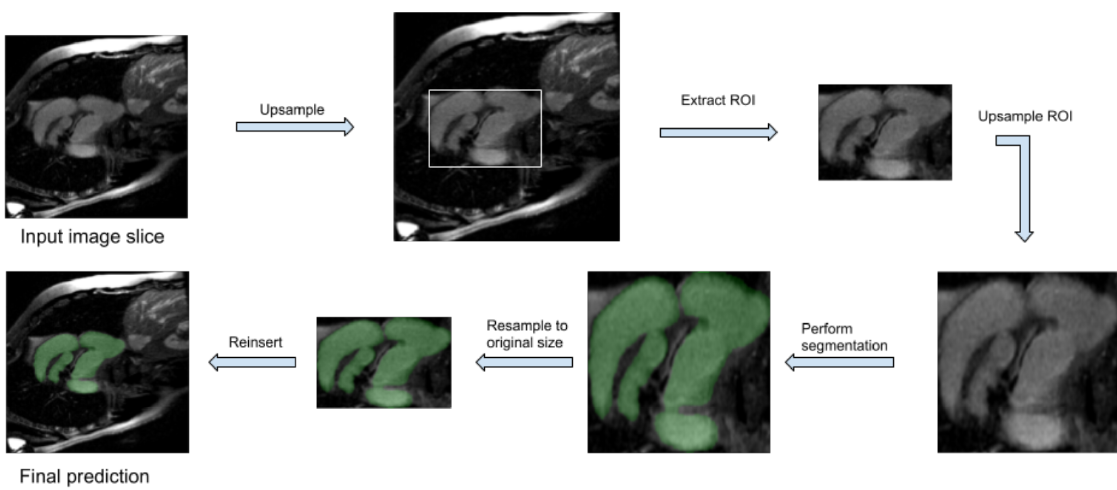
Figure 1. The flow-diagram that supports our approach. Before the training process starts, two scaling steps and a cropping step are performed: each original image slice is resized to 512 × 512 and, from this enlarged image, a ROI is cropped (by using the corresponding ground-truth) and resized to 224 × 224. The segmentation model is trained on these processed images and a set of masks are predicted for each input. Finally, the masks are re-scaled to the original dimensions and re-inserted in the original